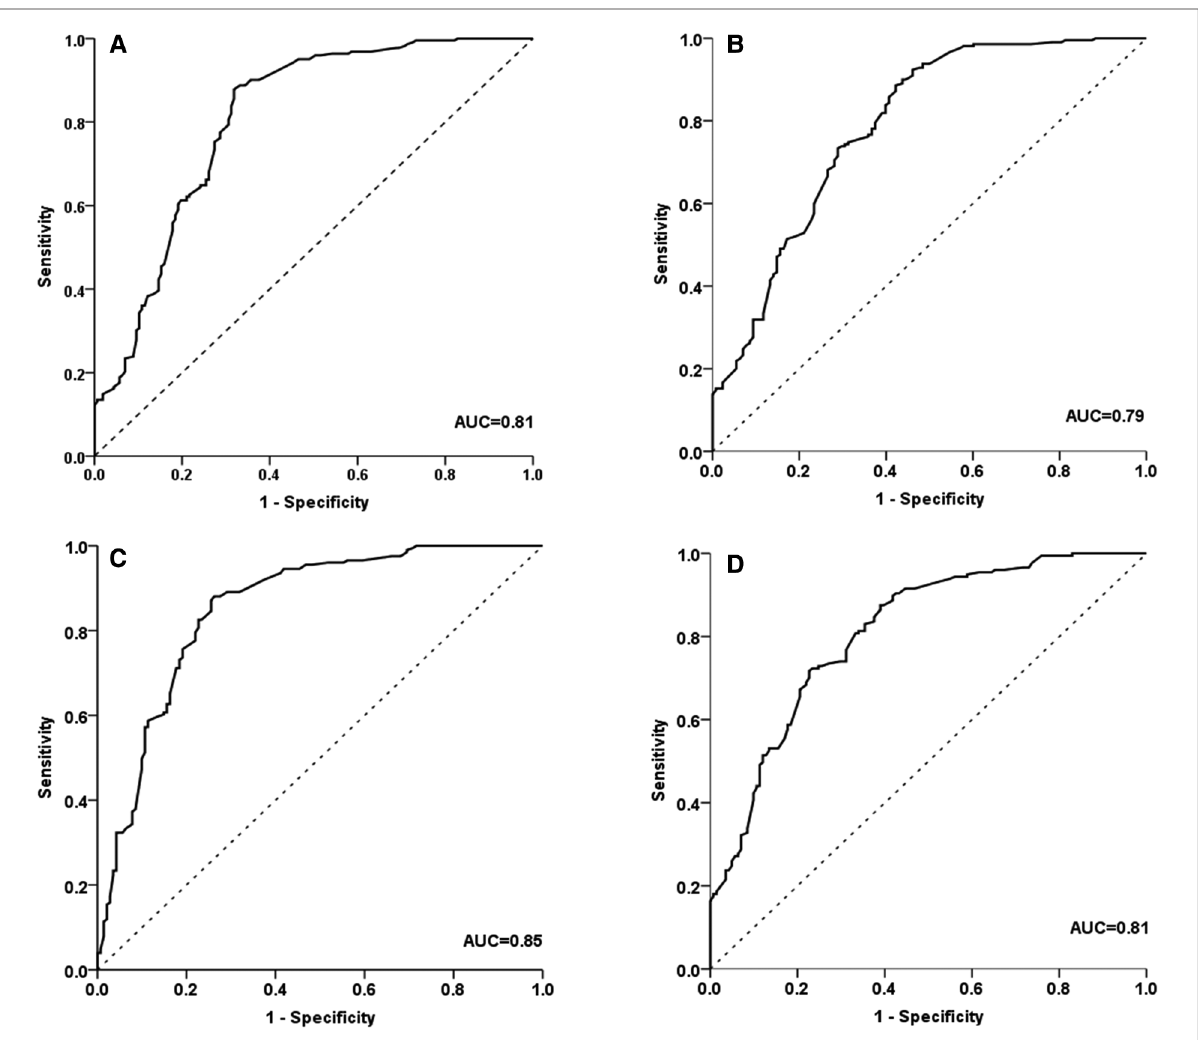
FIGURE 4 ROC curve analysis for determining six-minute walk test (6MWT) distance cut-off values in boys with a height of <130 cm ( A ); in boys with a height of ≥ 130 cm ( B ); in girls with a height of <130 cm ( C ); girls with a height ≥ 130 cm ( D ). ROC, receiver operating